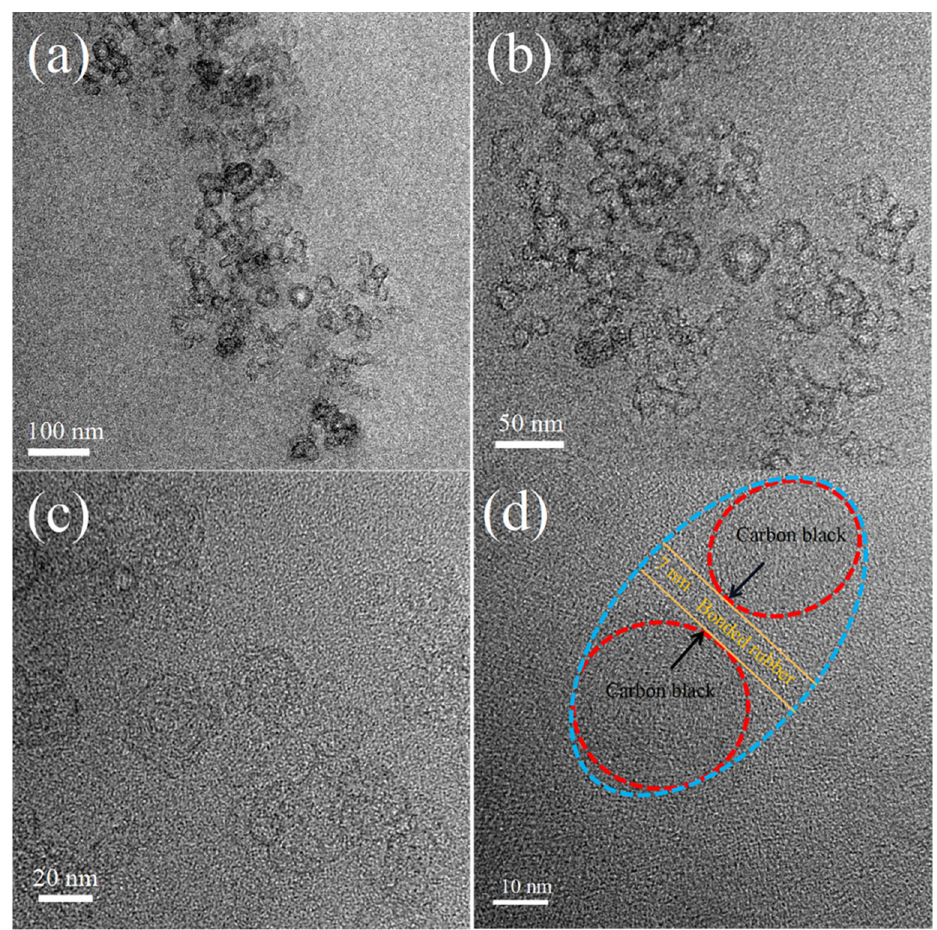
Figure 6. The HRTEM images of N115/NR nanocomposite with different magnifications, ( a ) 100 nm, ( b ) 50 nm, ( c ) 20 nm, and ( d ) 10 nm for the scale bar.